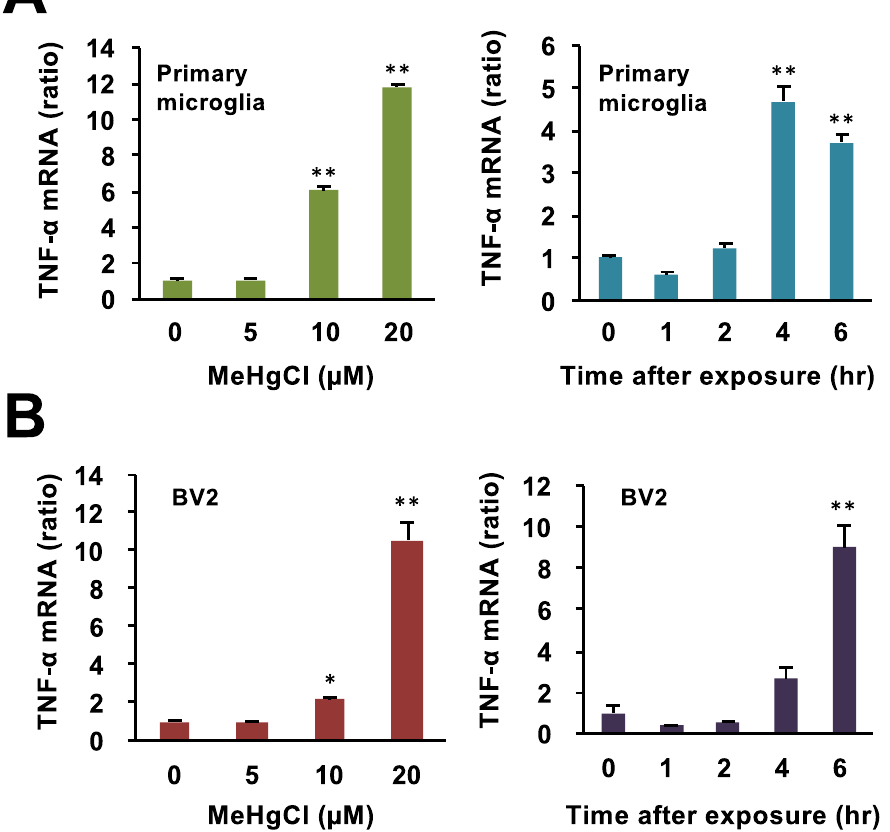
Figure 2. Effects of methylmercury on TNF-α expression in primary microglia and BV2 cells. ( A ) Mouse primary microglia were exposed to indicated concentrations of MeHgCl for 6 h (left panel) or 10 µM of MeHgCl for the indicated time course (right panel). The data are presented as GAPDH-corrected means ± standard deviations. ( B ) Mouse microglial cell lines (BV2) were exposed to indicated concentrations of MeHgCl for 6 h (left panel) or 20 µM of MeHgCl for the indicated time course (right panel). mRNA levels of TNF-α were measured by qPCR (n = 3). The data are presented as actin-corrected means ± standard deviations. The Y-axis indicates the ratio with the control as 1. * P < 0.05 vs control. ** P < 0.01 vs